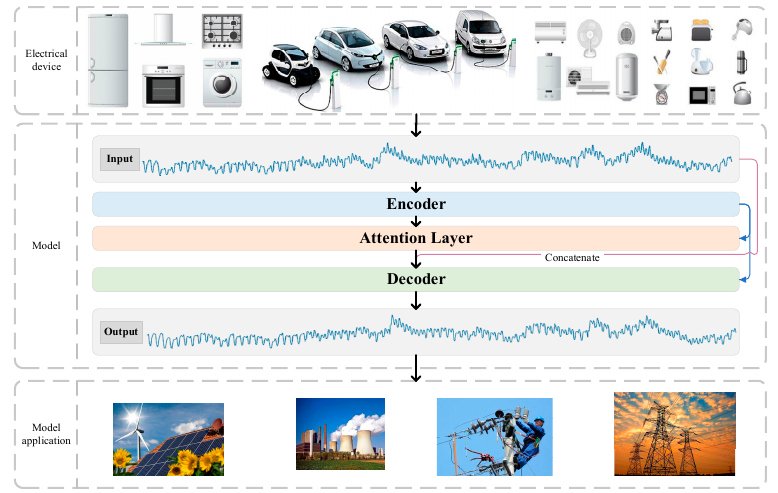
Figure 4. Load prediction system.